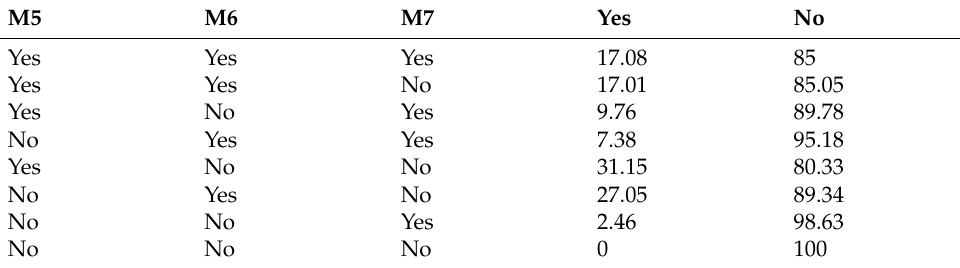
Table A11. Conditional probability of Top event